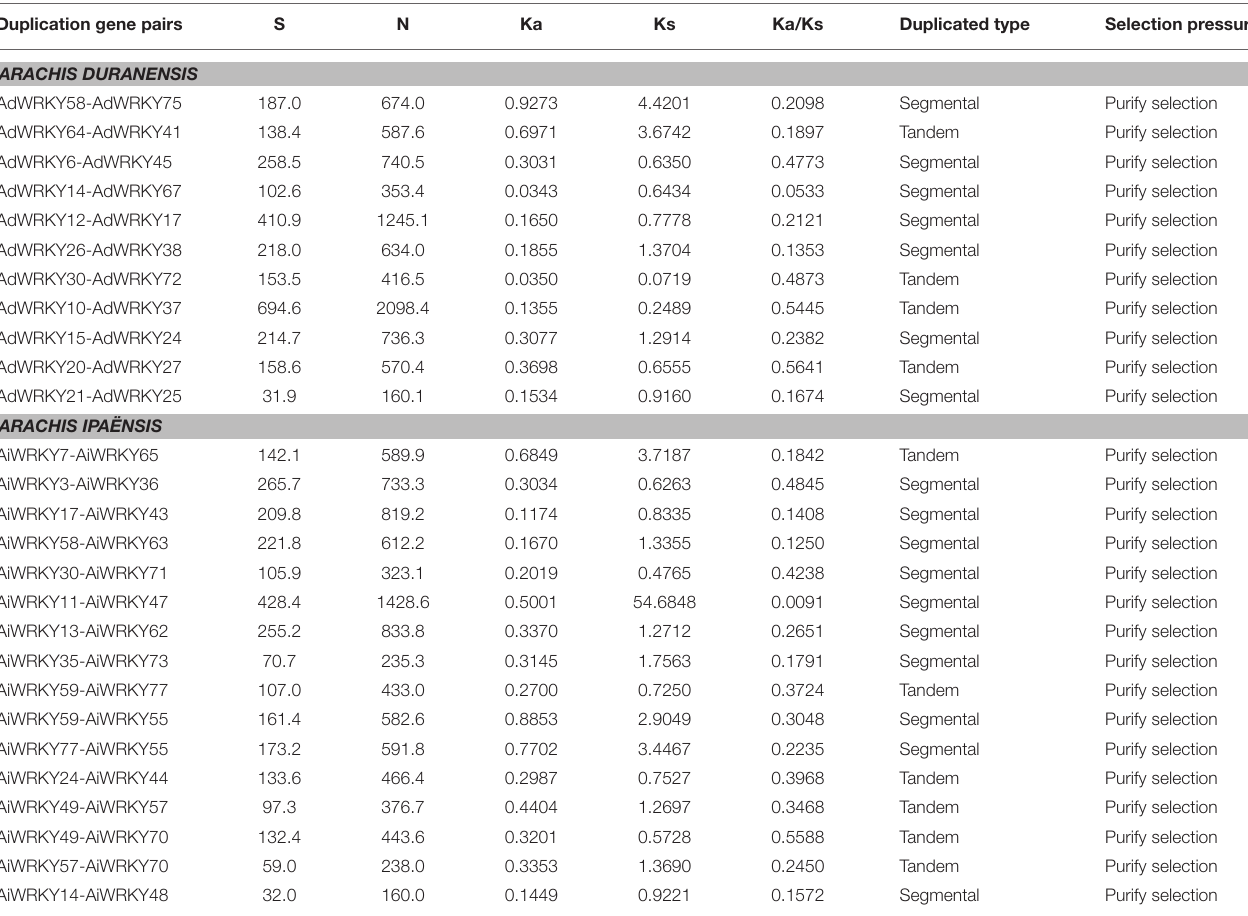
TABLE 3 | Ka/Ks calculation of each duplicated AdWRKY and AiWRKY genes